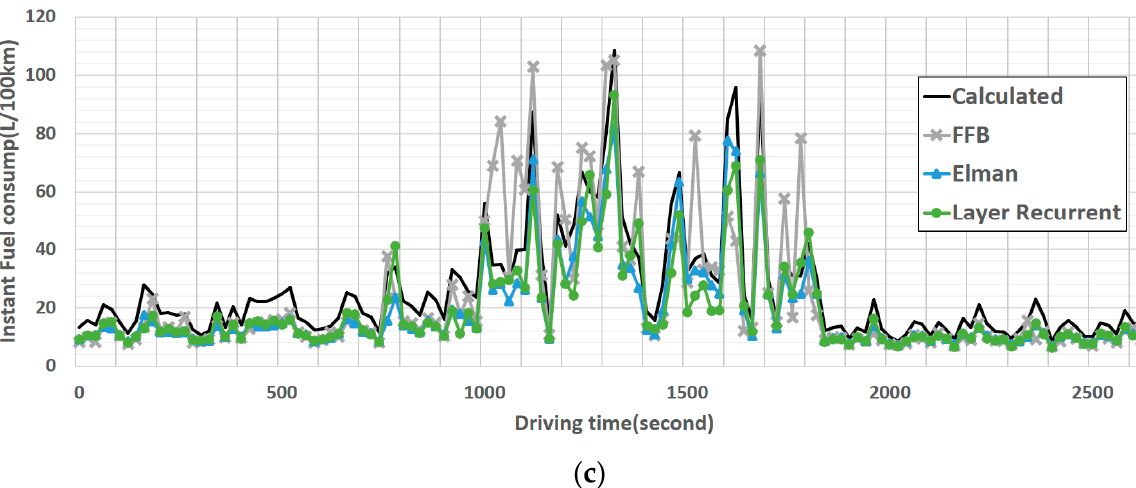
Figure 9. Comparison of calculated instant fuel consumption (black curve) with the values predicted using the FFB model (gray curve with crosses), Elman model (blue curve with closed triangles), and layer recurrent model (green curve with circles) for different cars: ( a ) Mitsubishi, ( b ) Mazda, and ( c ) Toyota.